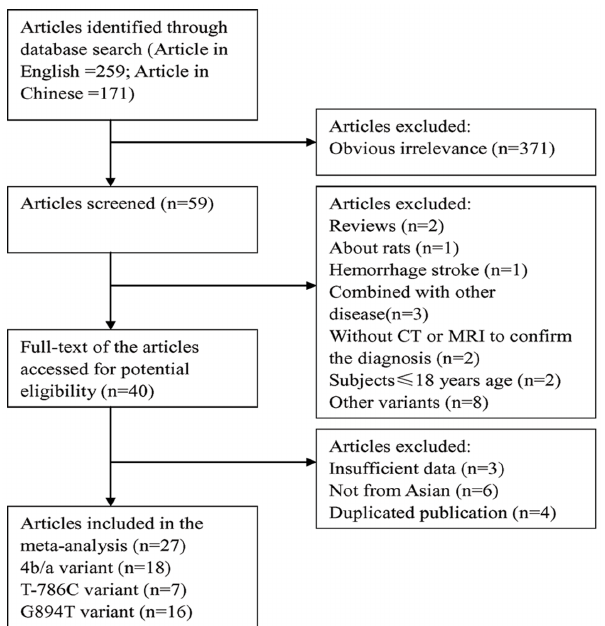
Figure 1. Flow chart of meta-analysis for exclusion/inclusion of studies.